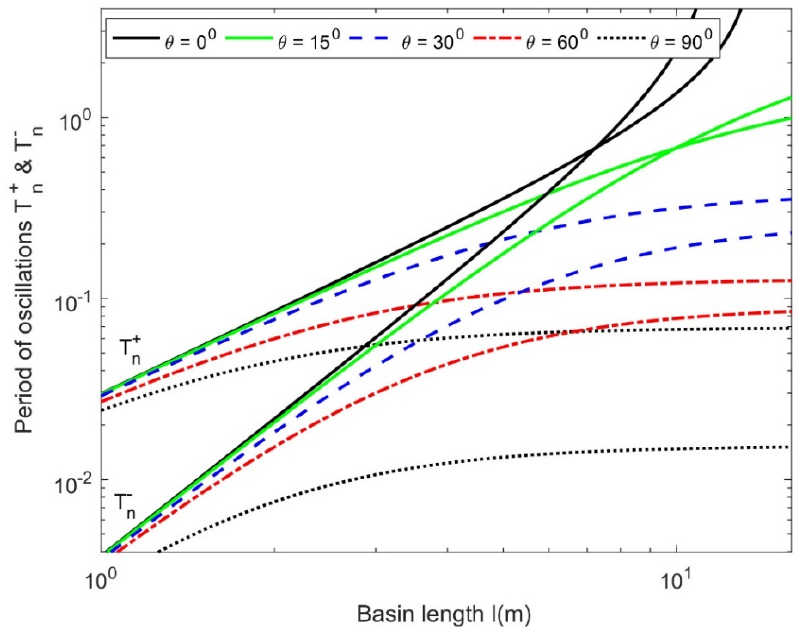
− T + and T − versus l (m) for different θ . Figure 16. Comparison between T + n and T n versus l (m) for different θ . n n